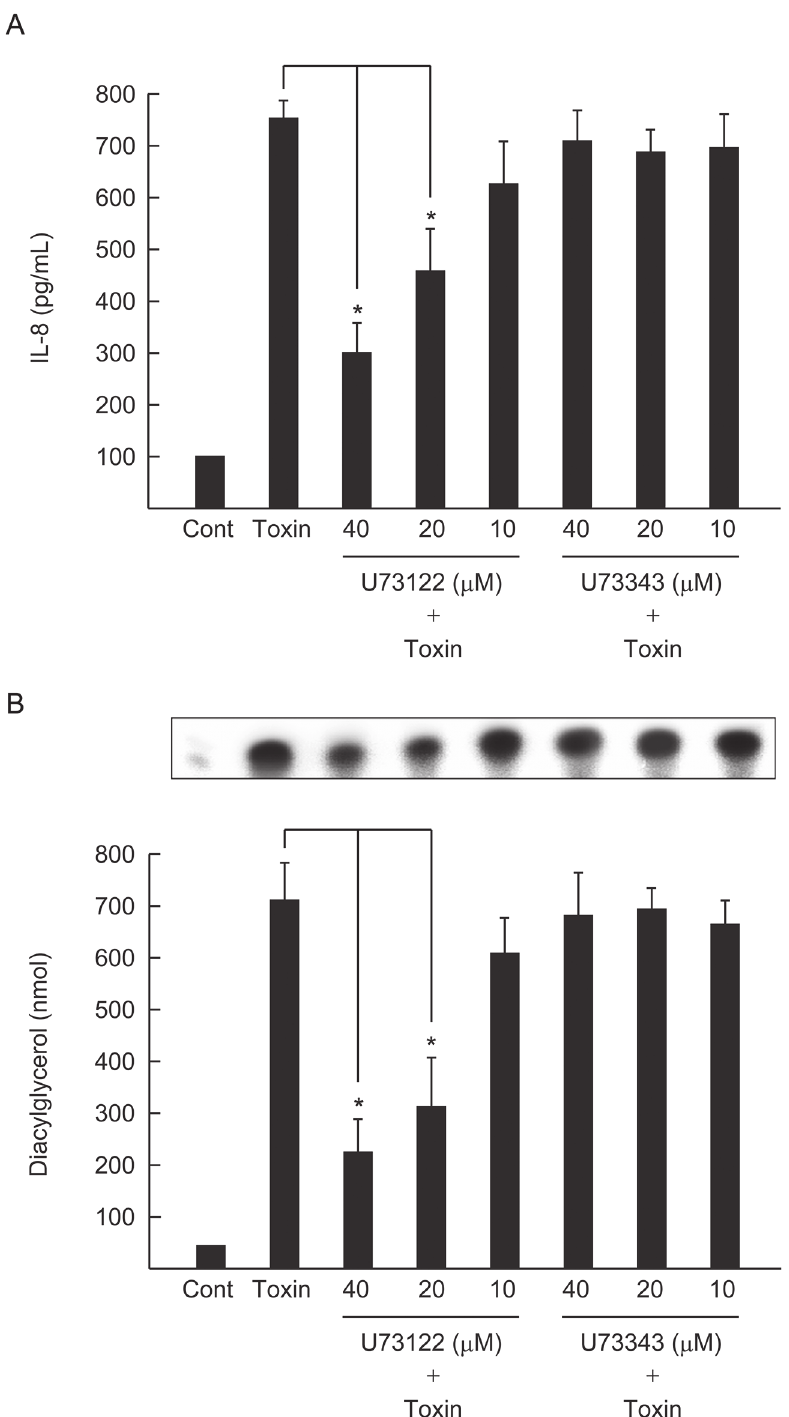
Fig 5. Inhibition of endogenous PLC prevented the alpha-toxin-induced release of IL-8 and formation of diacylglycerol. (A) A549 cells were pretreated with various amounts of U73122 or U73343 at 37°C for 60 min, and then incubated with or without alpha-toxin (1.0 μ g/mL) at 37°C for 3 h. The concentration of IL-8 in culture supernatants was determined by ELISA. (B) A549 cells were pretreated with various amounts of U73122 or U73343 at 37°C for 60 min, and then incubated with or without alpha-toxin (1.0 μ g/mL) at 37°C for 60 min and intracellular DAG levels were determined. Values represent mean ± S.E.; n = 4; * , p <